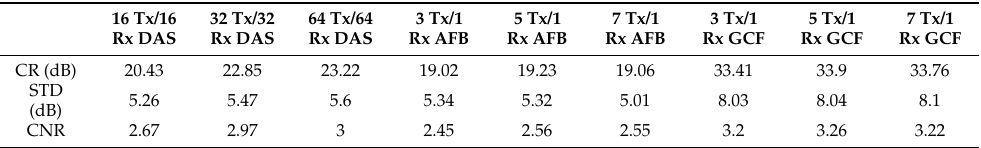
Table 3. Contrast (CR), standard deviation (STD), and contrast-to-noise ratio (CNR) of the images acquired using nine methods, as shown in Figure